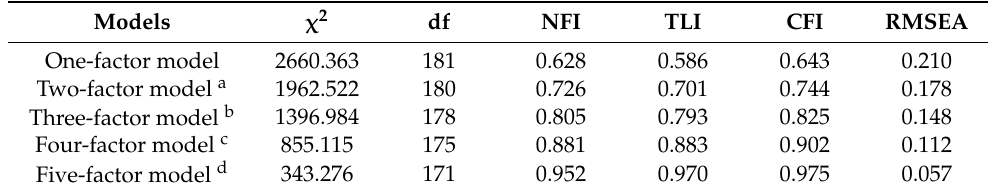
Table 2. Fit statistics for measurement models.